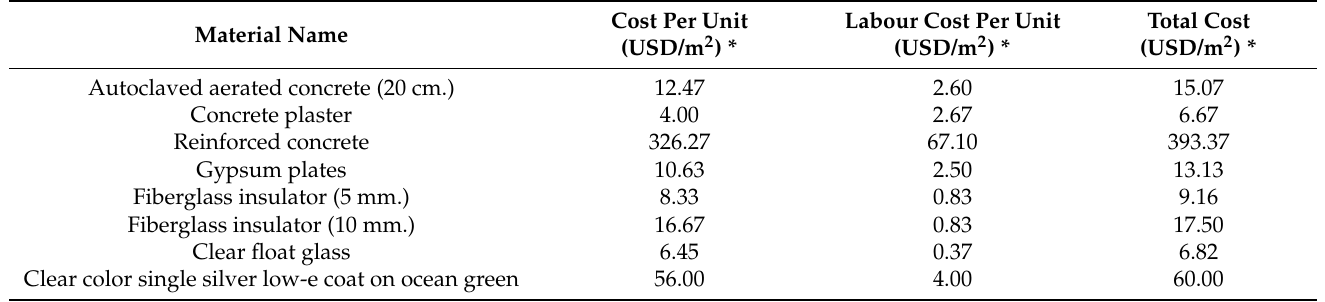
Table 17. Material and labor cost for retrofitted projects in the envelope section.